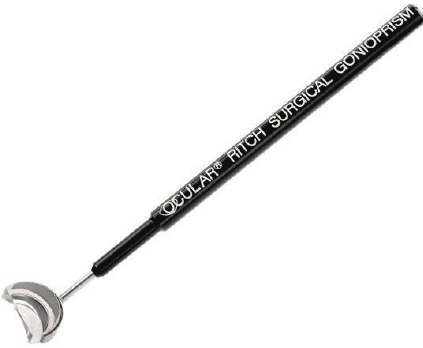
Figure 1: Ritch direct panoramic gonioscopy